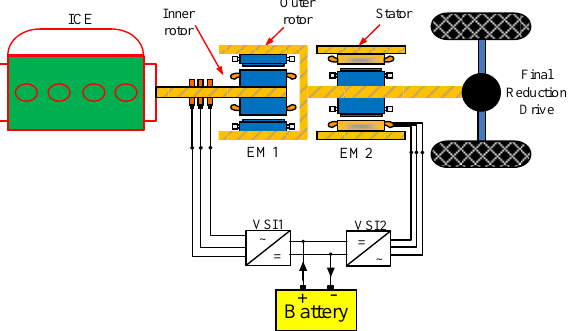
Figure 2. Power transmission topology of the separated CSM-HEV.